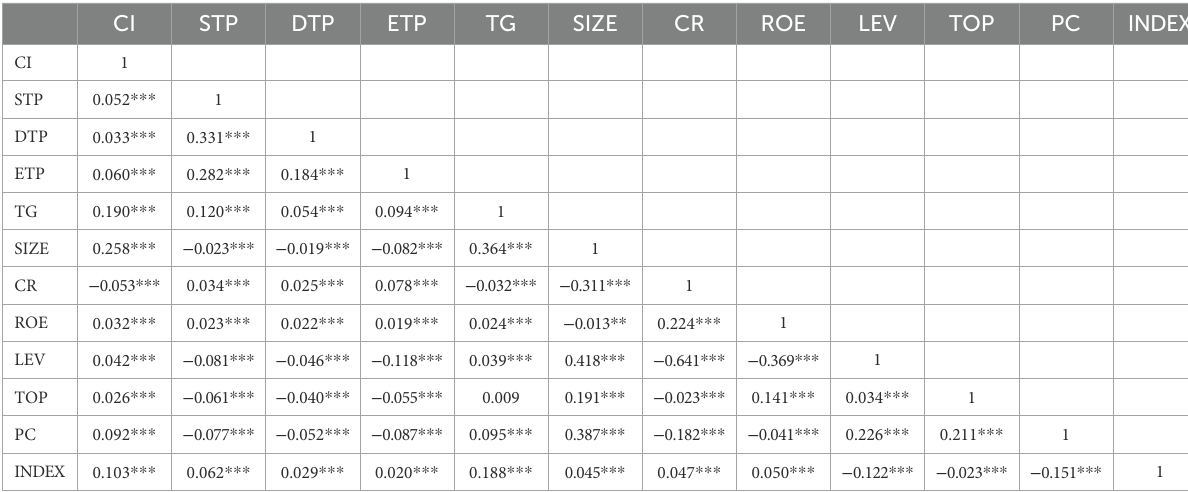
TABLE 4 Correlation matrix of main variables.